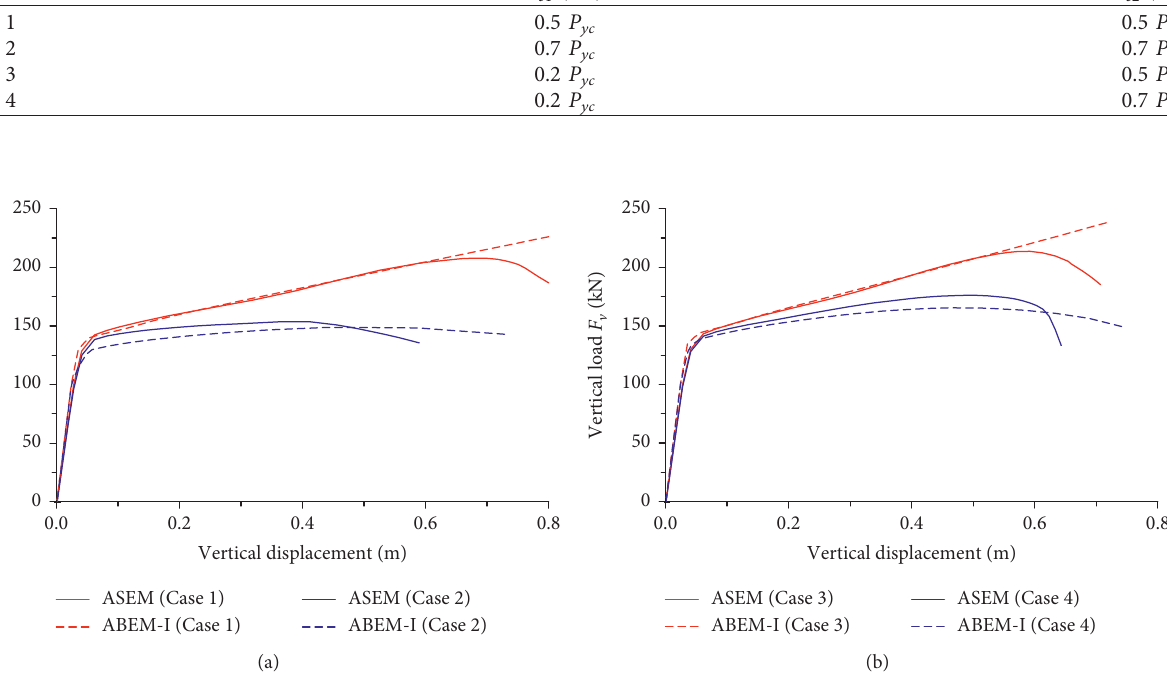
Figure 13: Load to vertical displacement curves of the ABEM-I and ASEM. (a) Cases 1 and 2. (b) Cases 3 and